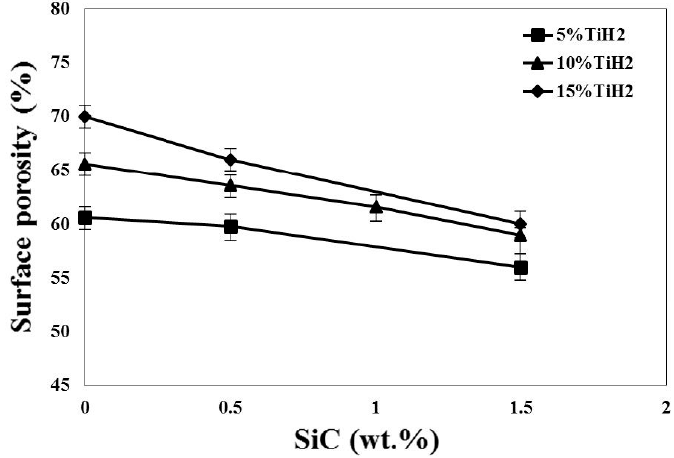
Figure 7. Effect of TiH 2 weight percentage on porosity.